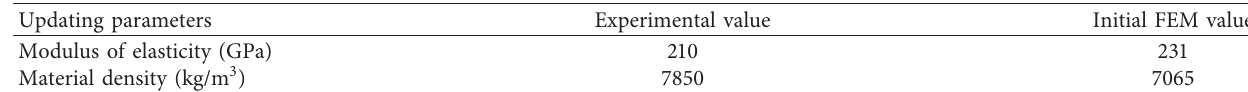
Figure 4: Comparison of ELM with RS and RBF model. (a) Initial FEM values and values predicted by ELM, RS, and RBF model. (b) RMSE of ELM, RS, and RBF model. Table 1: Parameters of experimental model and